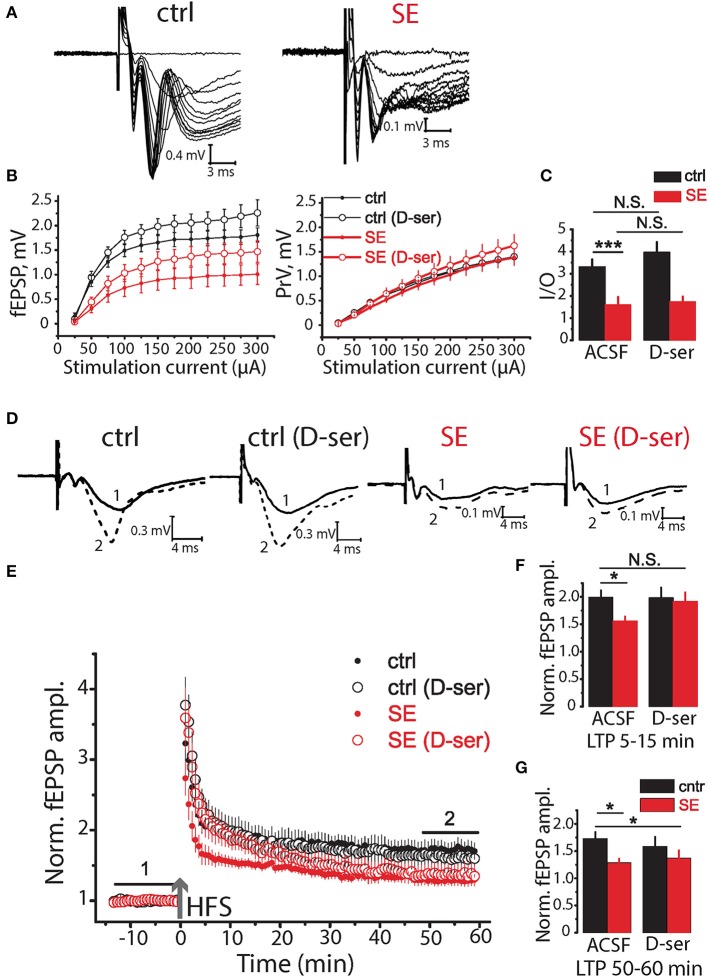
Effects of D-serine on synaptic neurotransmission in the hippocampus of control and SE-rats. (A) Representative examples of fEPSPs recorded in the hippocampal CA1 of control (ctrl) and SE-rats (SE). (B) Input-output (I/O) curves for the fEPSPs (left) and PrV (right). (C) Bar graphs showing the maximum slope of I/O curves for the fEPSPs. (D) Traces are the average of fEPSPs recorded during baseline (1) and 47–60 min after HFS (2). (E) LTP induced by HFS in the CA1 region of the hippocampus of control and SE-rats. Note that application of D-serine (D-ser) does not affect the magnitude of LTP in control rats but fully restored initial phase of LTP (5–15 min) in SE-rats. (F,G) The summary bar graphs showing significant reductions in LTP after SE as measured by the average normalized fEPSP amplitude and the effect of D-serine on initial (F) and later (G) phase of LTP. The bars with error bars are means ± SEMs. ***p < 0.01 *p < 0.05, N.S. p > 0.05 t-test.